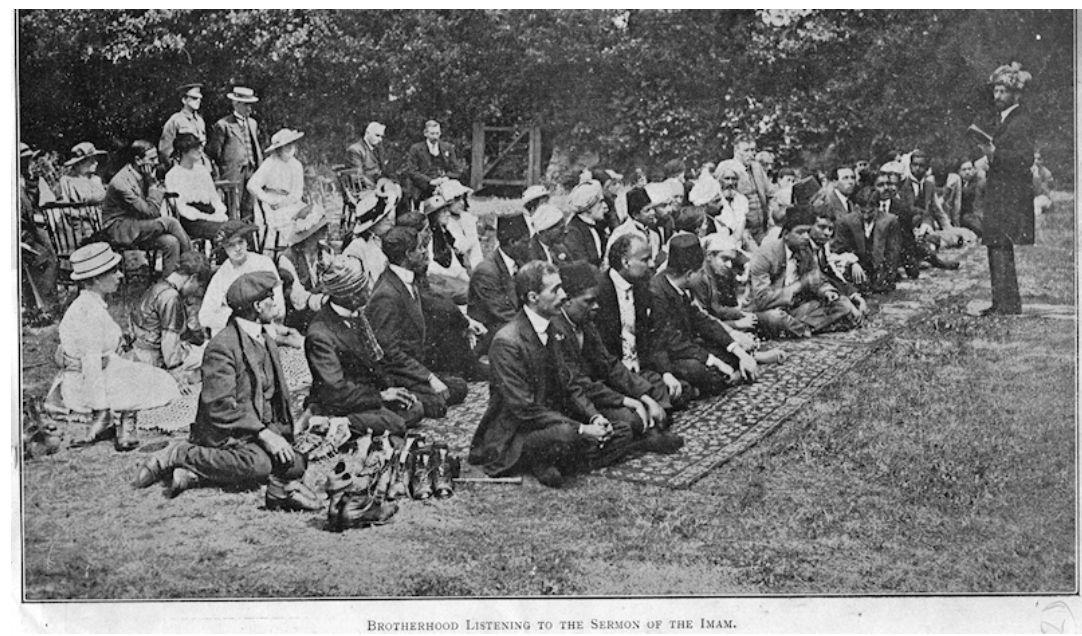
Figure 1. This is a photograph of an Eid prayer from the Woking Mosque sometime between 1914 and 1916. Women are clearly visible both as members of the congregation and as observers. Image courtesy www.wokingmuslim.org.